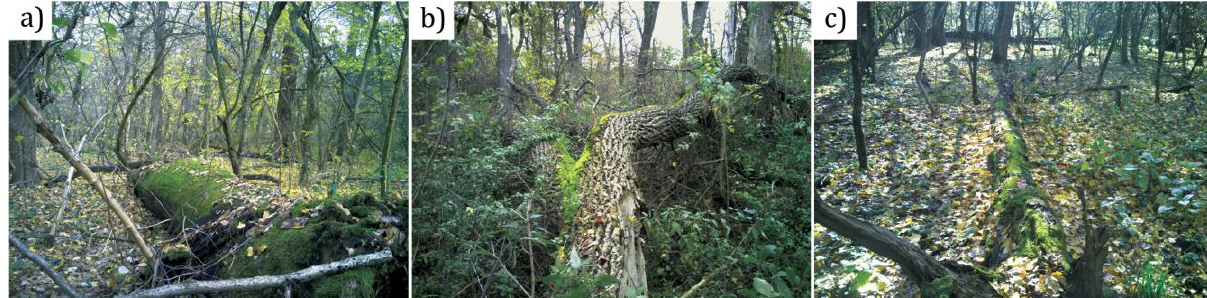
Figure 4 : Examples of detected downed stems in the study site (a, b), and an example for an un-detected stem due to high degree of decay and small diameter